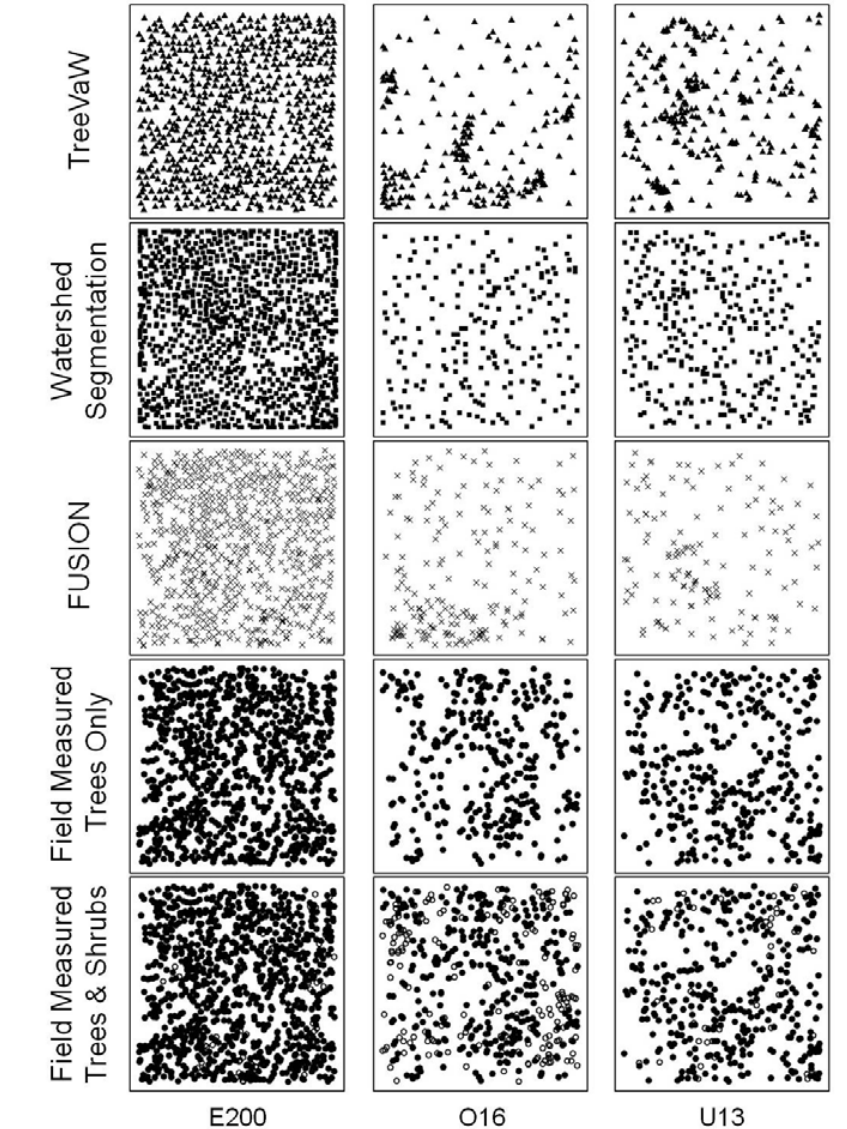
Figure 5. LiDAR tree extraction method comparison for plots representing even aged (E200), old growth (O16), and uneven aged (U13) conditions. The figure rows (ordinate) contain images of the plotted tree/vegetation stem locations by method and the columns (abscissa) are the corresponding plots. Field measured points are displayed with trees (solid dots), shrubs (hollow dots), and with trees